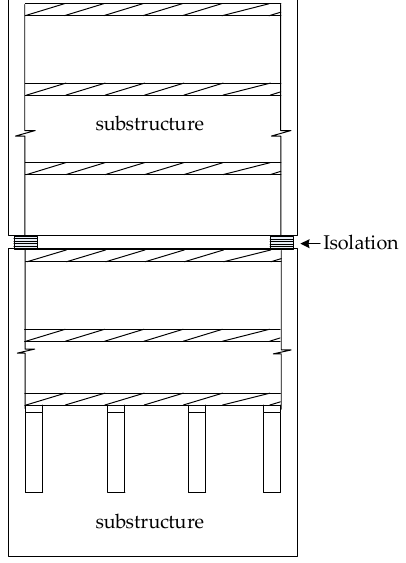
Figure 1. Configuration of the seismically isolated structures.